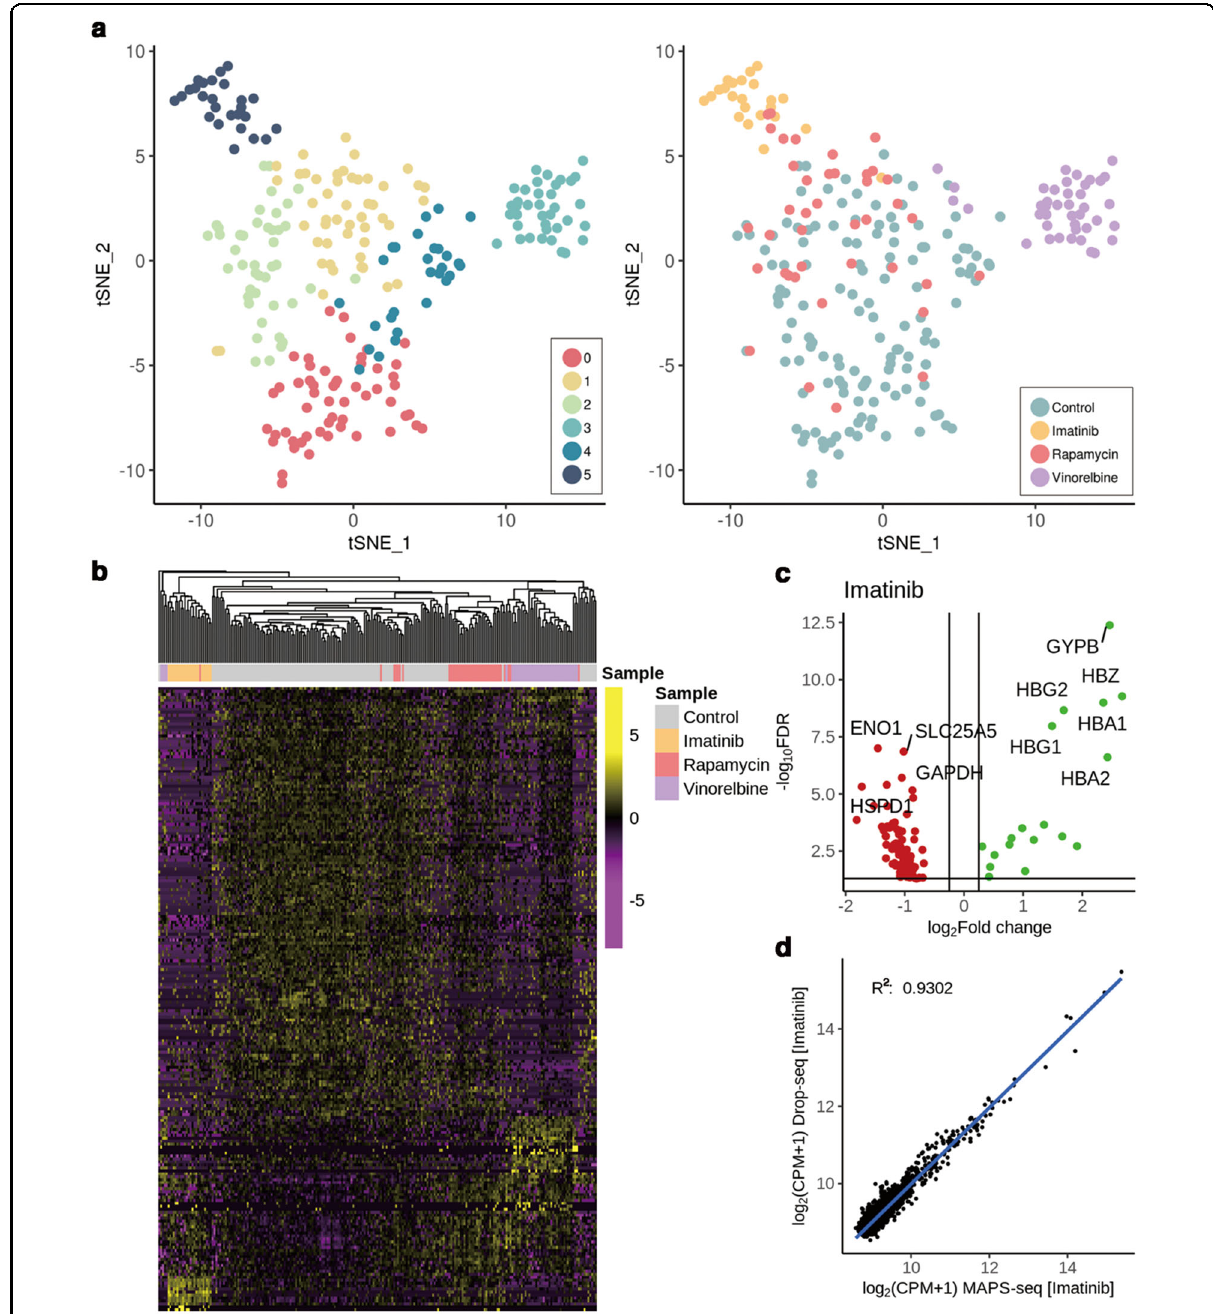
Fig. 3 Gene expression analysis in drug treatment experiments. a t-SNE visualization of single cells identi fi ed by performing unsupervised clustering analysis using DGE data in drug treatment experiments via MAPS-seq (left). Clusters were numbered randomly. The original information about the sample is overlaid on the cluster analysis in the right panel. b Hierarchically clustered heatmap of gene expression pro fi les for drug treatment experiments in each K562 cell. Each column represents the expression value from the drug, and each row represents a gene. The heatmap is constructed from differentially expressed genes. c Volcano plot displaying differentially expressed genes of the imatinib-treated cells compared with the DMSO-treated controls. Genes with a p value <0.05 and an absolute value of log 2 fold change (FC) > 0.25 are considered signi fi cant. Upregulated genes are green, downregulated genes are red, and noncritical genes are gray. The ten genes with the lowest p values are labeled. The cutoff for upregulation was log 2 FC > 0.25 and the false discovery rate (FDR) was <0.05. The cutoff for downregulation was log 2 FC < − 0.25 and the FDR was <0.05. d Gene expression correlation for imatinib between MAPS-seq and